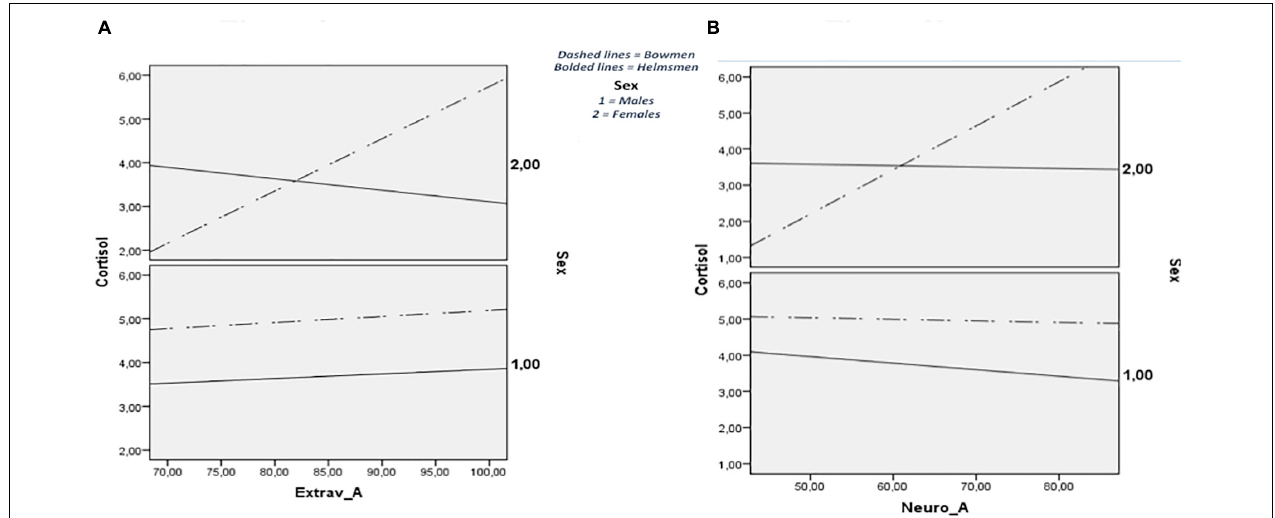
FIGURE 2 | A three-way interaction effect, Extraversion (A) , Neuroticism (B) .